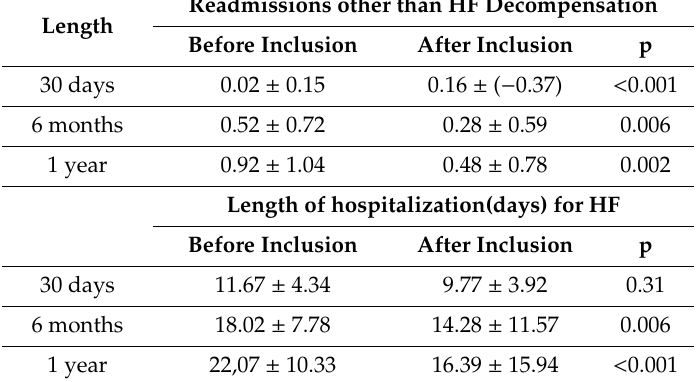
Table 4. Mean number of readmissions other than heart failure decompensation and length of hospitalization for heart failure before and after inclusion in the PRADO-IC program (at 30 days, 6 months, and one